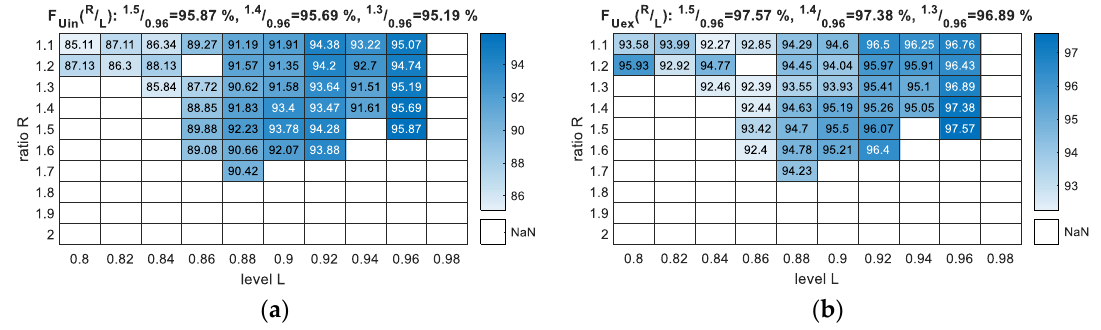
Figure 6. F -measure output for the parameterisation of the NTF method with R and L variables (training data vs. training data): ( a ) F Uin —scores with U class included as an error; ( b ) F Uex —scores with U class excluded from measure.